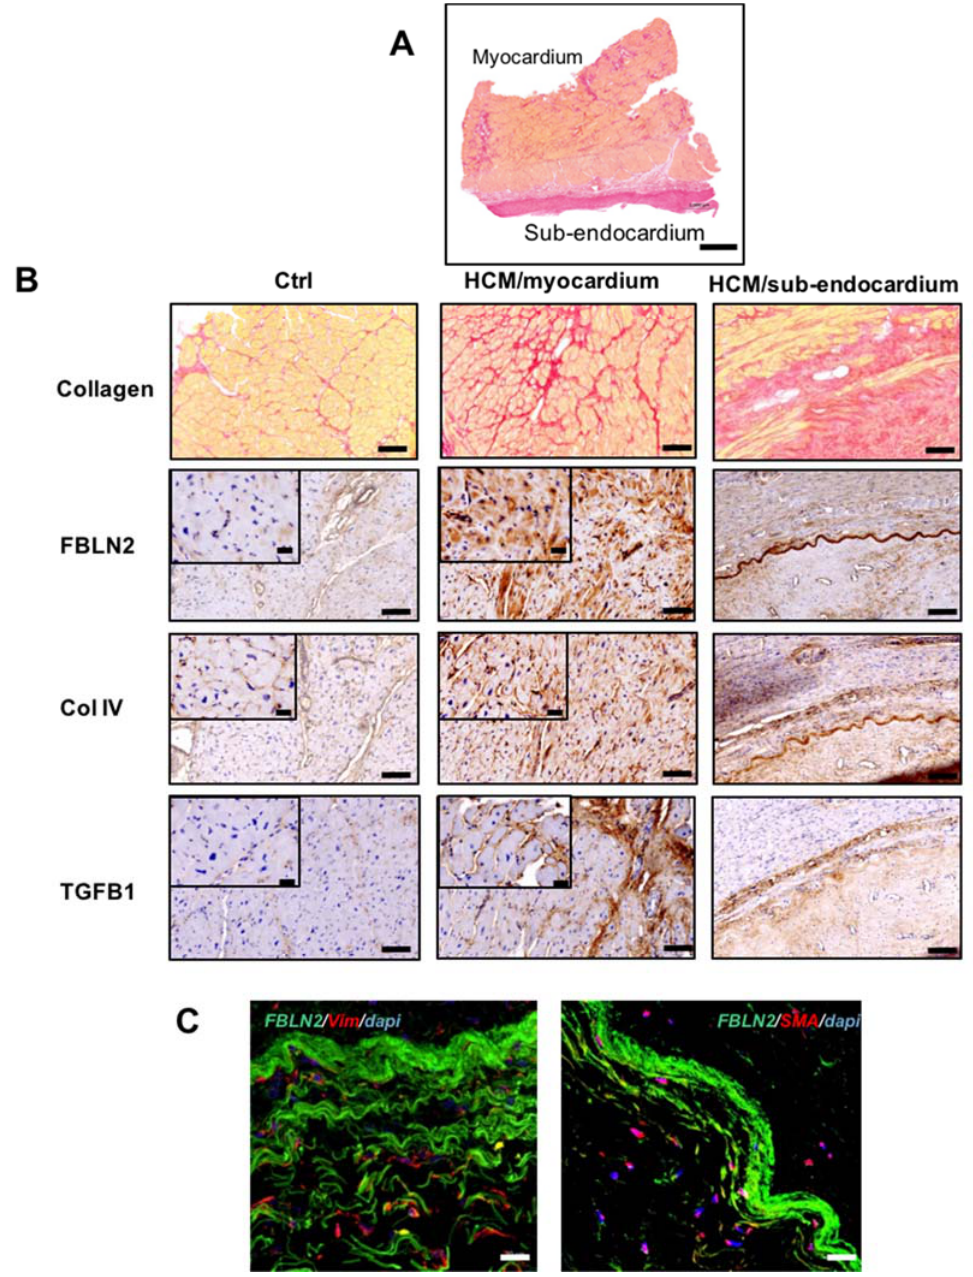
Figure 2. FBLN2 expression and localization in HCM myectomy tissues along with Col IV and TGF β 1. ( A ) A representative transmural section of a myectomy specimen stained with picro-Sirius red and shows fibrosis distribution in the myocardium and sub-endocardium. Scale bar is 1 mm. ( B ) Picro-sirius red and immunohistochemical analysis of HCM tissues at the myocardium and sub-endocardial ( n = 79), compared to controls ( n = 9), showing FBLN2, Col IV, and TGF β 1 expression. Scale bars are 100 (overview) and 20 µ m (magnified insets). ( C ) Confocal microscopy imaging shows Vim + and SMA + cells (red) infiltrating the FBLN2 sheath (green) at the sub-endocardial region (representative of 3 HCMs vs. 3 controls). Scale bars are 20 µ